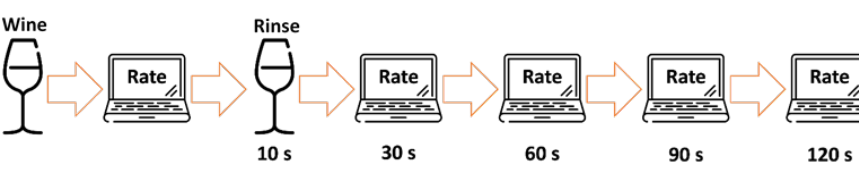
Figure 7. Flowchart of the fixed-time-point evaluation procedure employed in study